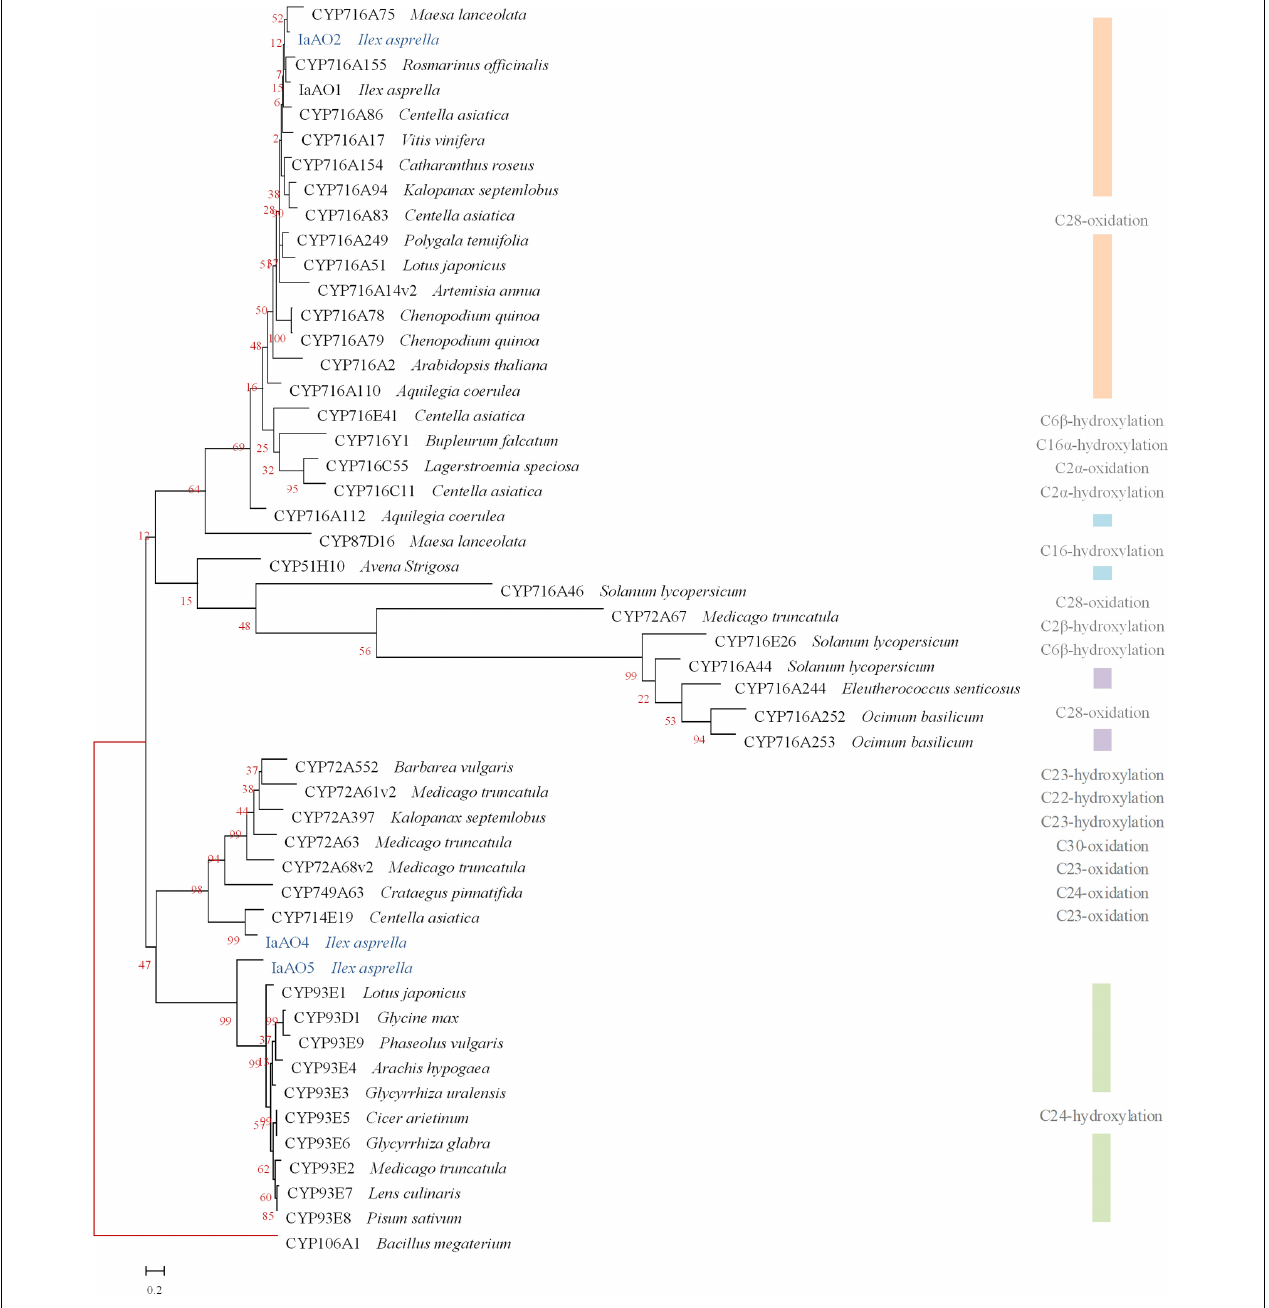
FIGURE 2 | Phylogenetic analysis of IaAO2, IaAO4, and IaAO5 with known triterpene CYPs. The relevant gene names and amino acid sequences are given in Supplementary Material . Genes isolated in this study were colored in blue. Red branches represented outgroup. Scale bar indicated the number of amino acid